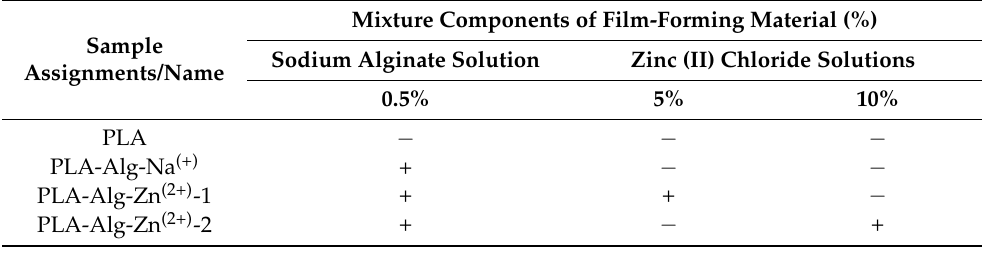
Table 2. Composition of the dip-coating solution of poly(lactide) (PLA) surface modifier (%).